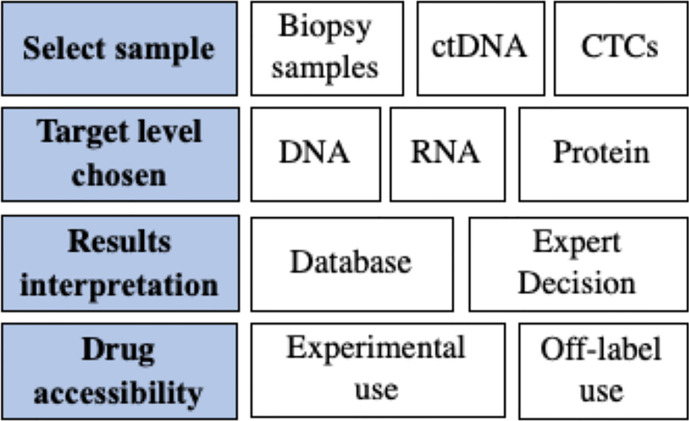
Summary of unsolved questions and future directions.